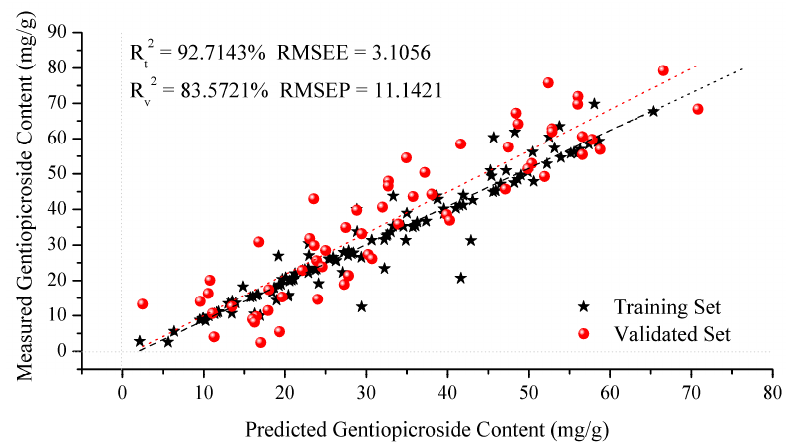
Figure 7. Correlation diagram between FT-IR predicted values and the reference values in the training and validation sets for gentiopicroside.